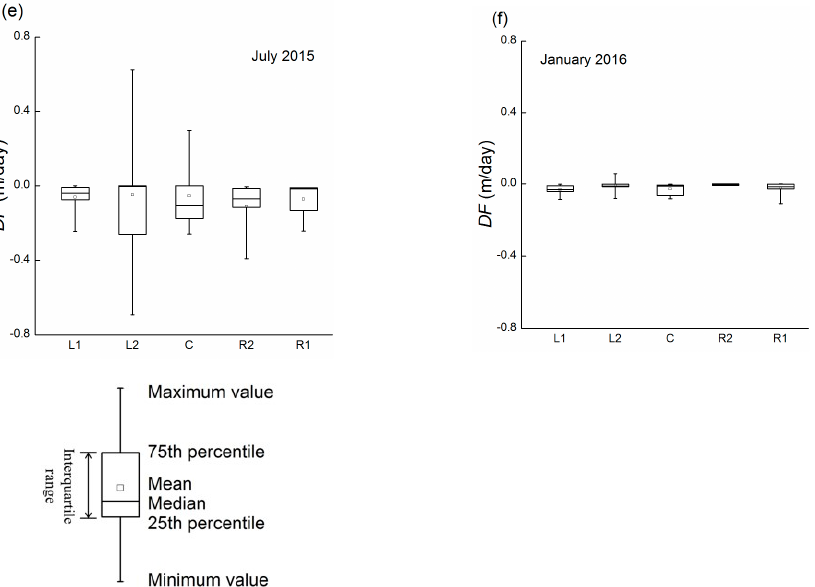
Figure 3. Box plots of K v ( a , b ), VHG ( c , d ), and DF ( e , f ) for July 2015 and January 2016.